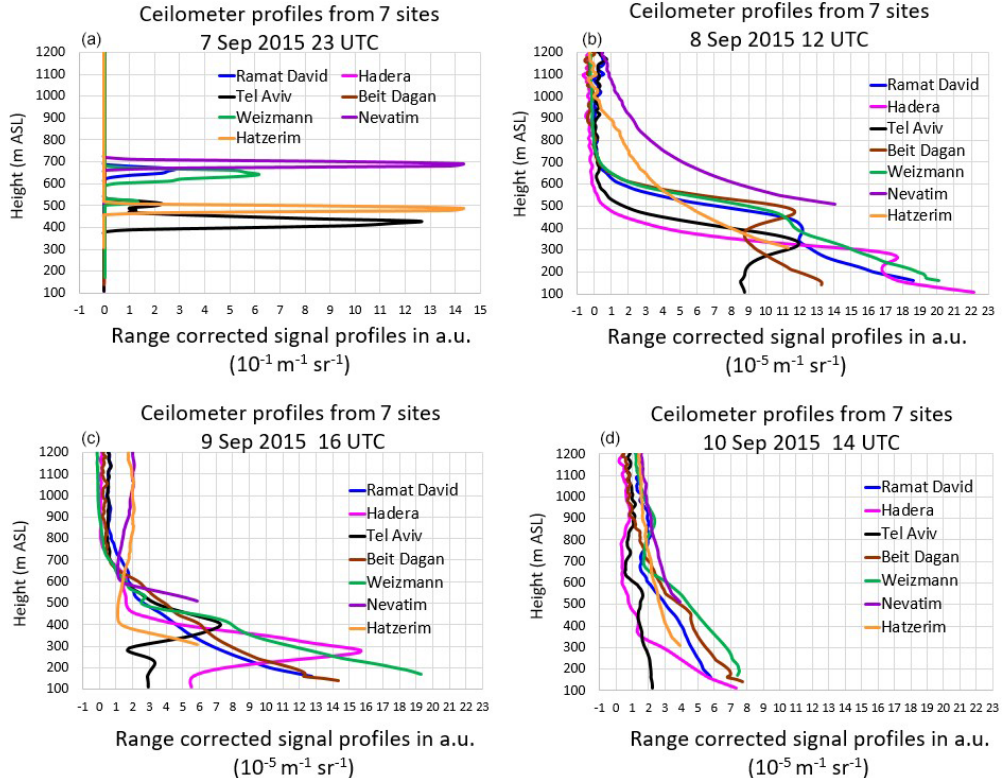
Figure 17. Ceilometer range-corrected signal profiles (in arbitrary units) from seven sites (Ramat David, Hadera, Tel Aviv, Beit Dagan, Weizmann, Nevatim and Hatzerim; see locations in Fig. 3) on 7 September 2015 at 23:00UTC (a) , 8 September 2015 at 12:00UTC (b) , 9 September 2015 at 16:00UTC (c) and 10 September 2015 at 14:00UTC (d) . Notice that each profile begins relatively to the height of its measuring site (a.s.l.), including a deletion of data from the first 100ma.g.l. due to inaccuracies in the first range gates of the ceilometers (for details, see Sect. 2.1). Panel (a) shows cloud detection; therefore, it is given in a different scale (10 − 1 m − 1 sr − 1 ) and a different x -axis